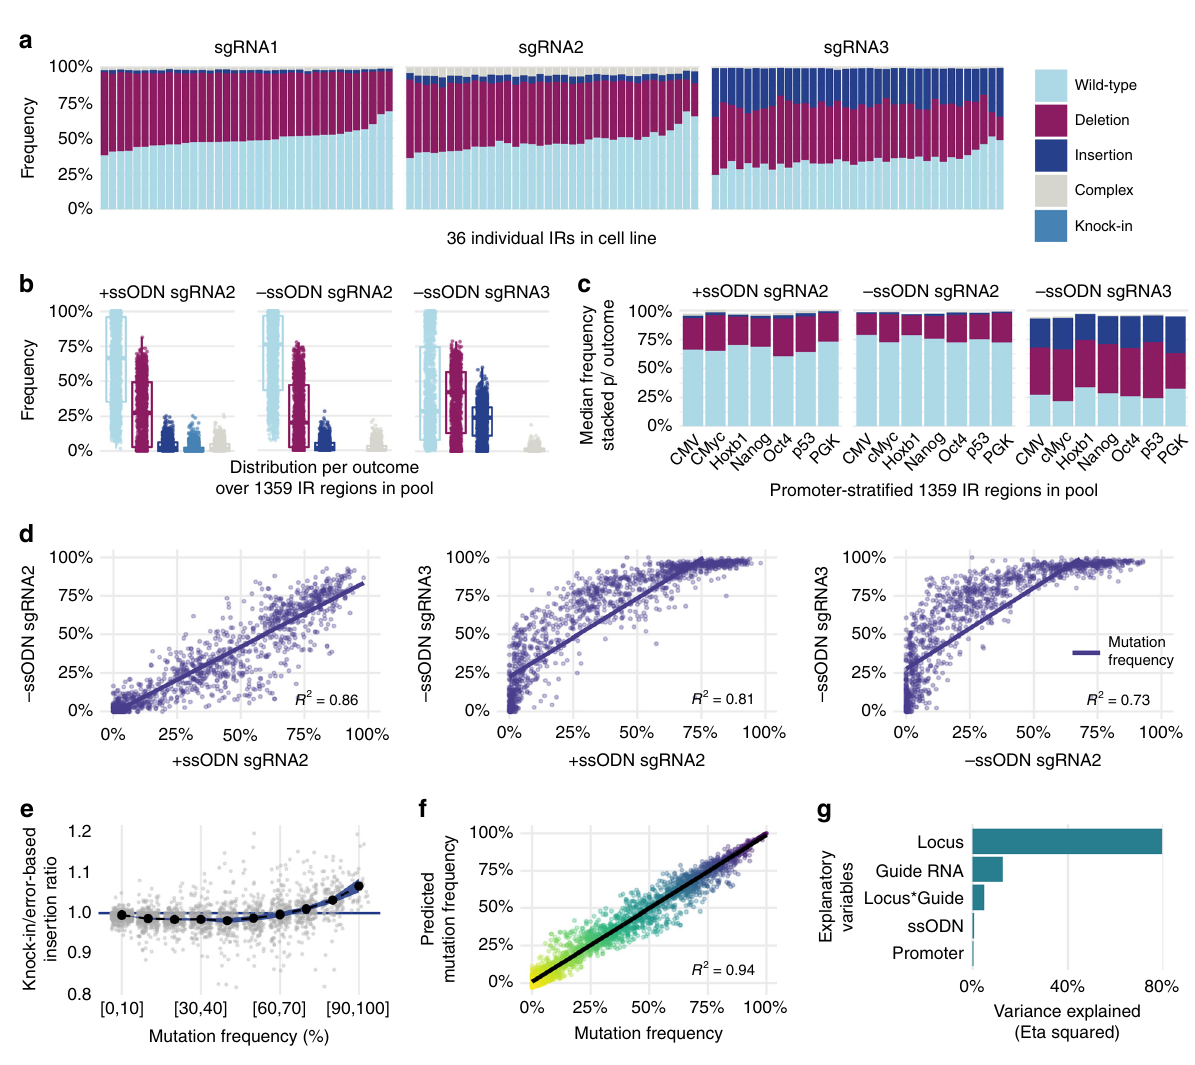
Fig. 2 Contribution of IR locus, guide RNA, promoter and ssODN to Cas9-induced mutation frequency. a Frequency per outcome in cell line Cas9 assays, showing effects of IR locus and guide RNA. Each bar represents one of 36 IRs in the cell line, and each colored band denotes the fraction of reads exhibiting a particular outcome among all reads mapped to such IR (vertical axis). Outcomes: wild-type in light blue, deletion in red, insertion in dark blue, and complex mix of mutations in beige. b Frequency per outcome in TRIP pool assays, for guide RNA and ssODN inclusion combinations. Dots denote frequency (vertical axis) per outcome (color) for 1359 IRs with at least 30 reads in all assays. Boxes show the median, fi rst and third quartiles of the frequency distributions; whiskers extend to 1.5 times the inter-quartile range from the top and bottom of the box. c Frequency per outcome in TRIP pools, strati fi ed by promoter. Each bar denotes the subset of IRs associated with a given promoter; colored bands denote median frequency per outcome. d Correlation of IR mutation frequency across TRIP pool assays. Each dot indicates mutation frequency of a given IR in two different experiments (horizontal and vertical axes). Linear regression lines and corresponding R 2 values denote correlations. e Ratio between knock-in and error-based insertions (vertical axis) with respect to binned IR mutation frequency (horizontal axis). Grey dots indicate ratios for individual IRs, black dots denote mean ratios within bins, blue ribbon shows 0.95 con fi dence interval around the mean. f Goodness-of- fi t of linear regression model predicting mutation frequency based on IR locus, guide RNA, ssODN, promoter, and (locus, guide) interaction term. g Effect size or variance explained by variables in the regression model. Plotted are eta squared values for multi-way ANOVA tests based on type II sum of squares. Source data are provided in the Source Data fi